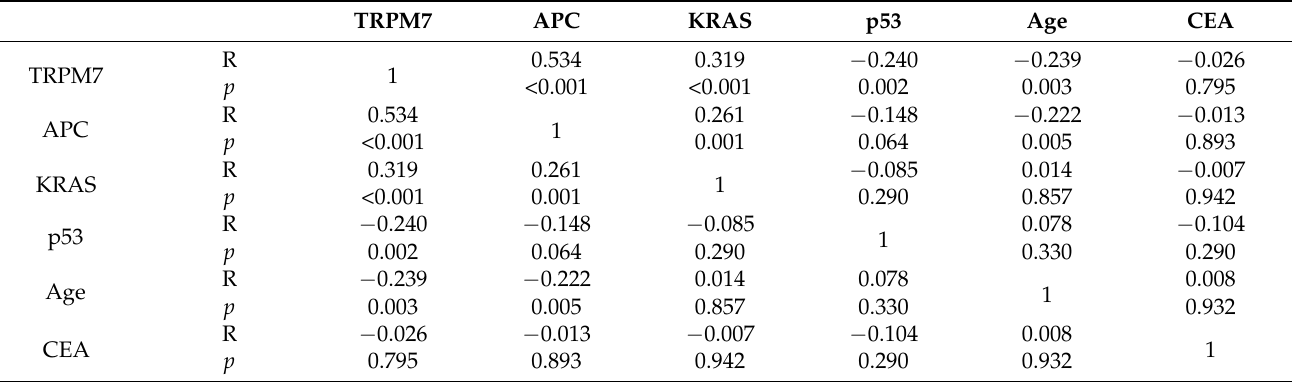
Table 2. Correlation analysis in rectal cancer.